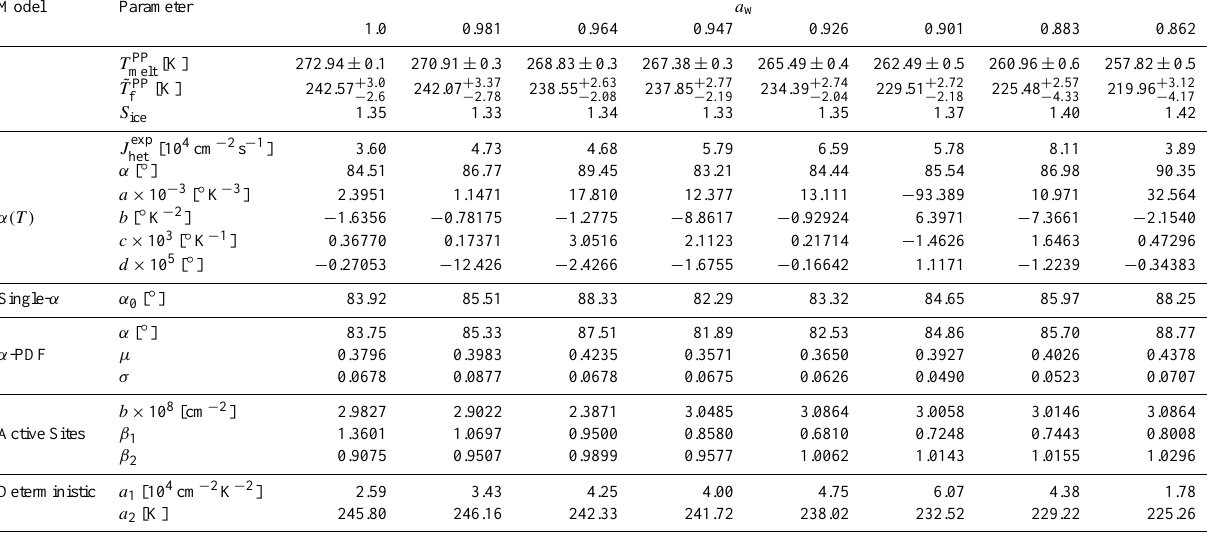
, ± 1 σ ), median freezing temperature ( ˜ T PP melt ); heterogeneous ice nucleation rate coefficient ( J exp f